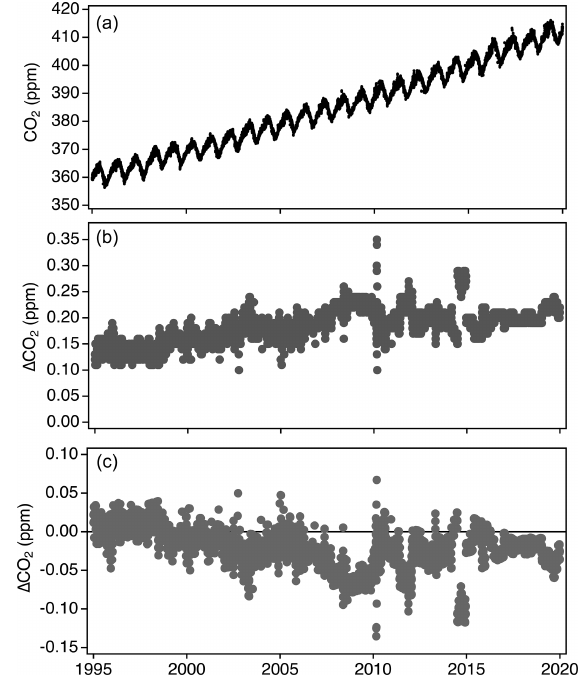
Figure 15. Hourly averaged CO 2 measurements from Mauna Loa Observatory fully reprocessed to X2019 (a) , the difference between the fully reprocessed X2019 data and X2007 (b) , and the differ- ence between using the linear scale conversion and full reprocessing methods to determine X2019 values (c)